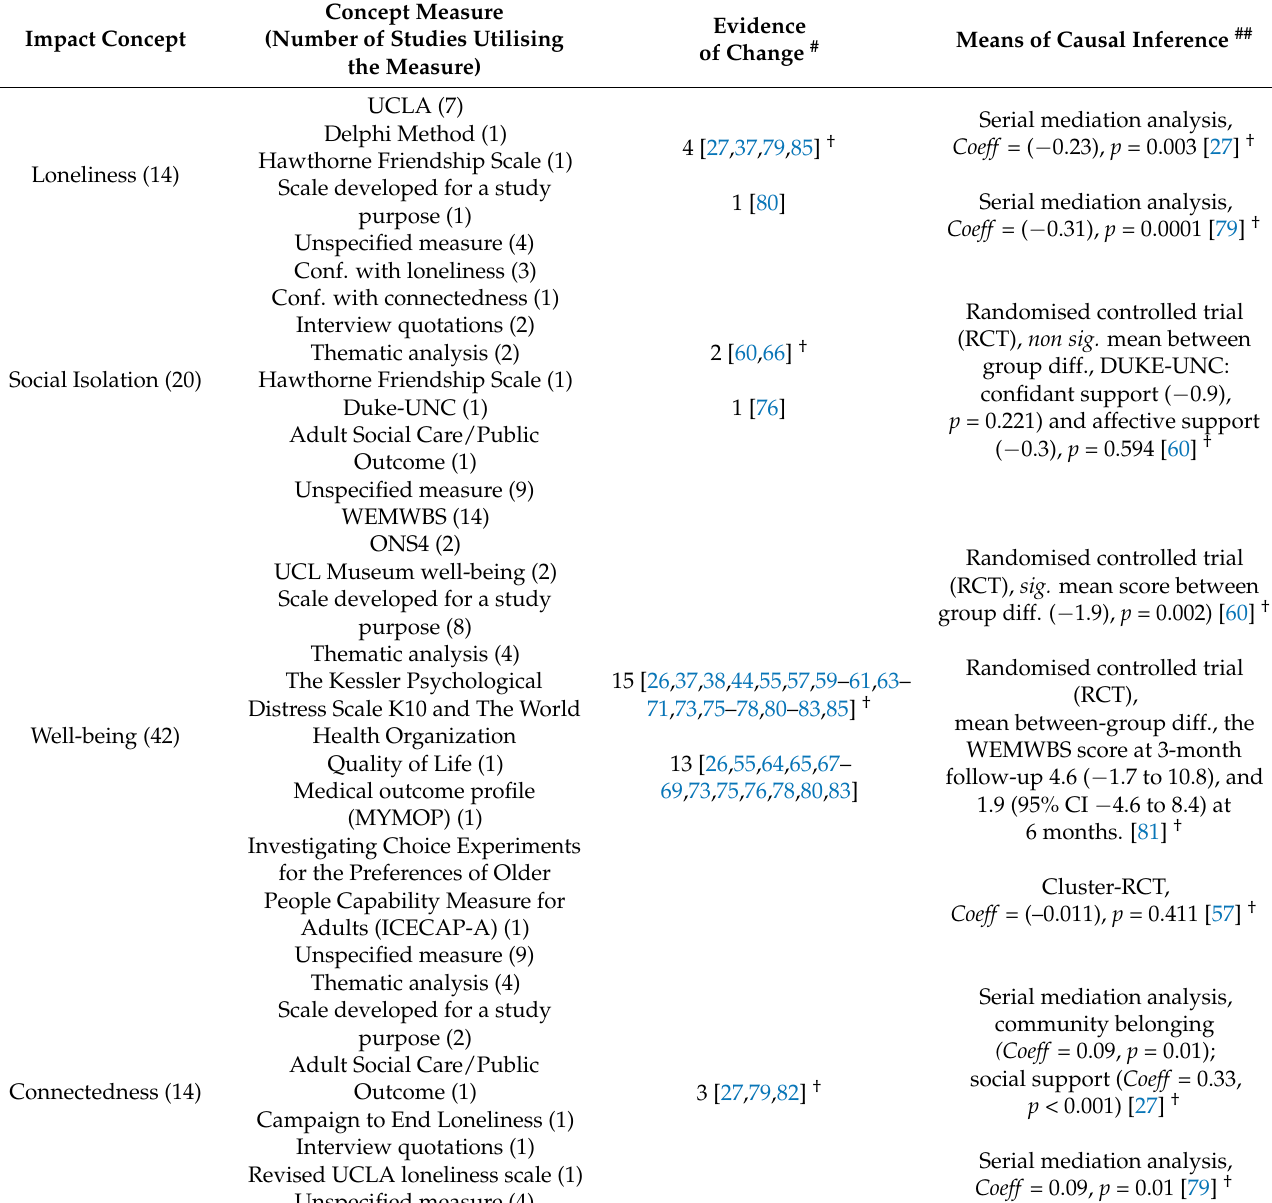
Table 1. Summary Table of 51 articles that evaluate social prescribing programmes according to individual-level